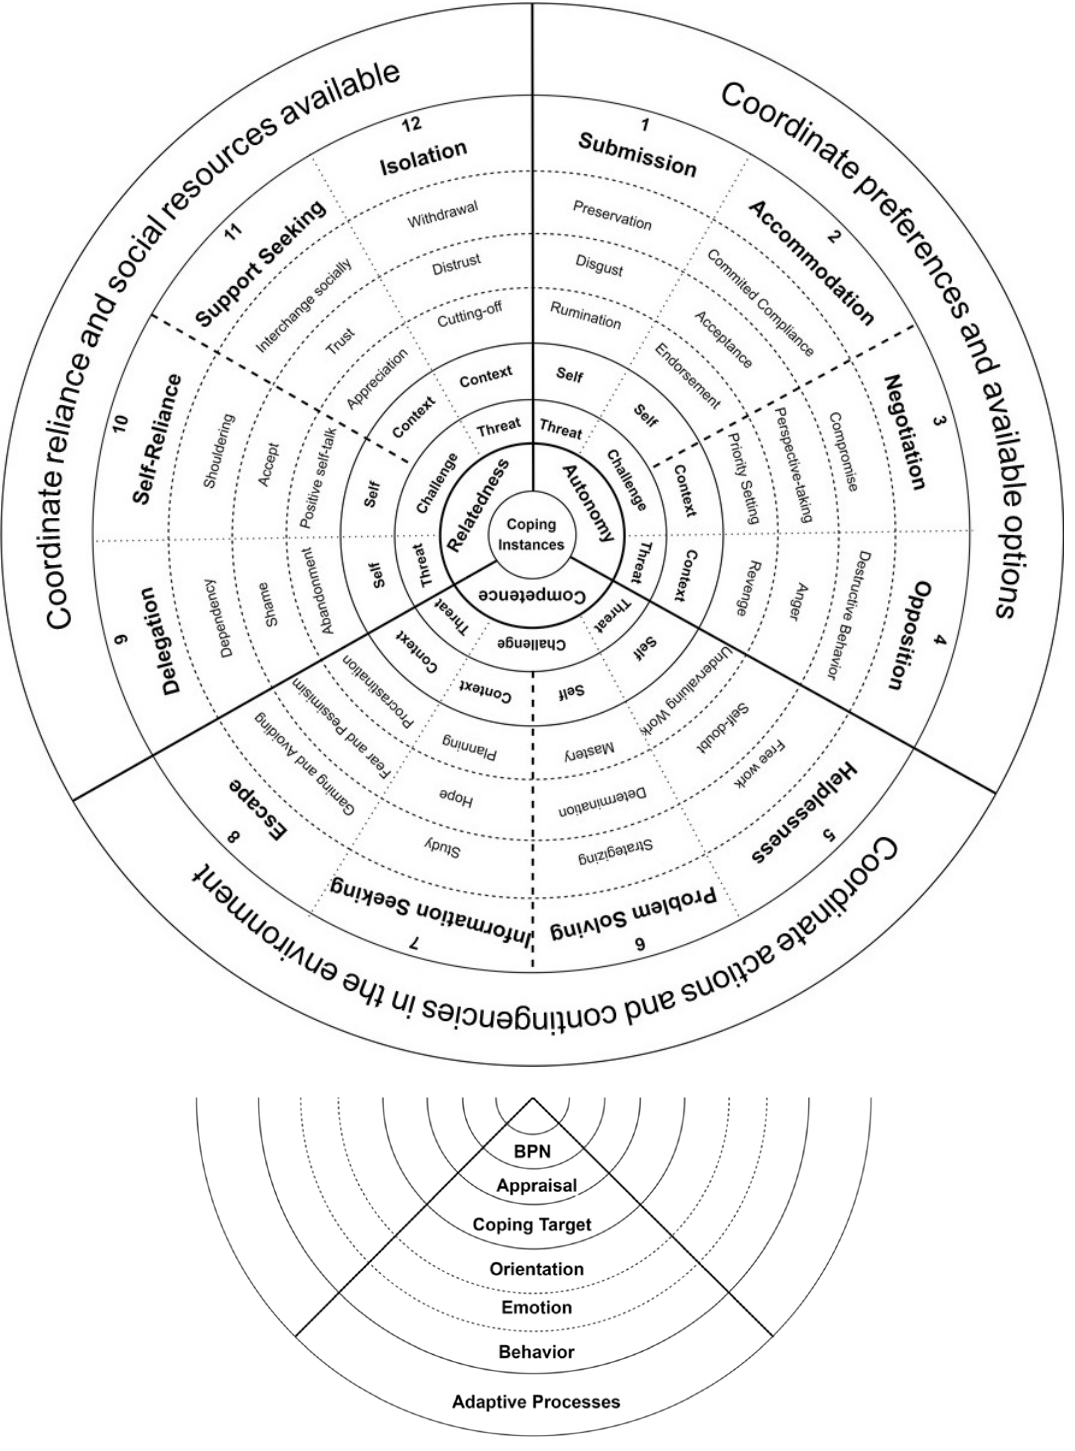
Figure 1. A radar view of 12 families of coping in gig work and a corresponding reading guide based on multiple dimensions of coping involved. Note: BPN = basic psychological needs.